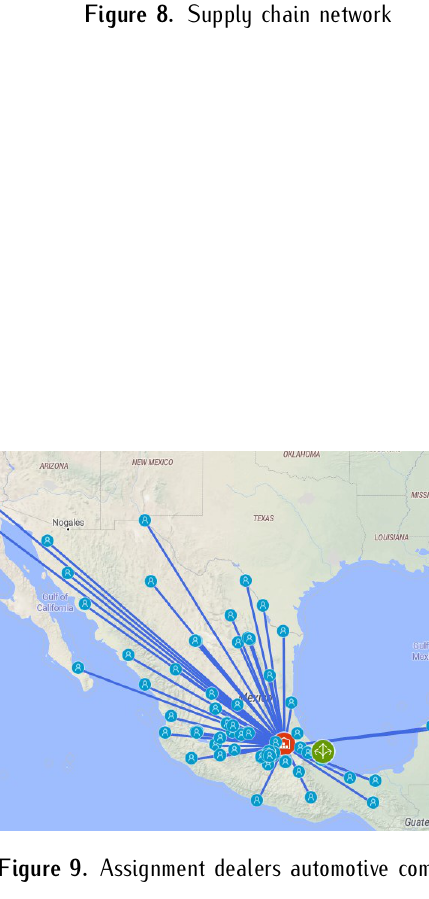
Figure 8. Supply chain network